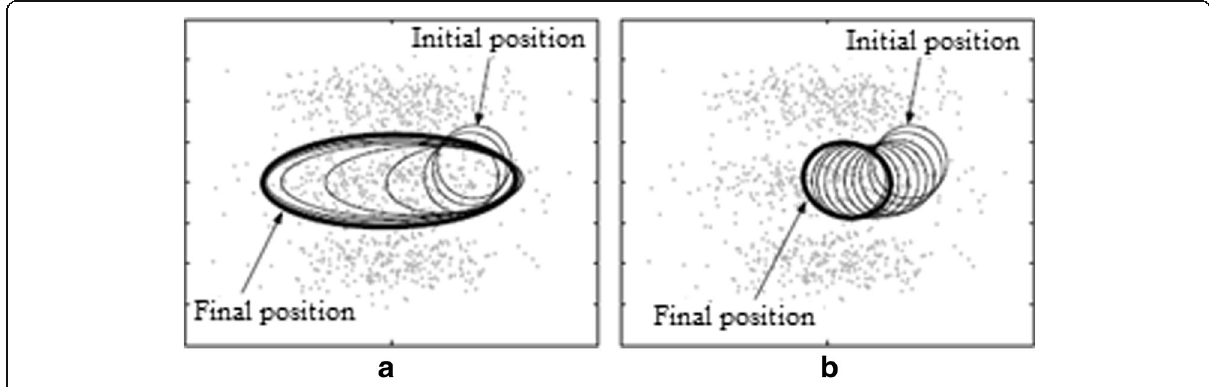
Fig. 8 Performance of two algorithms in target searching. a Mean-shift. b Extended mean-shift